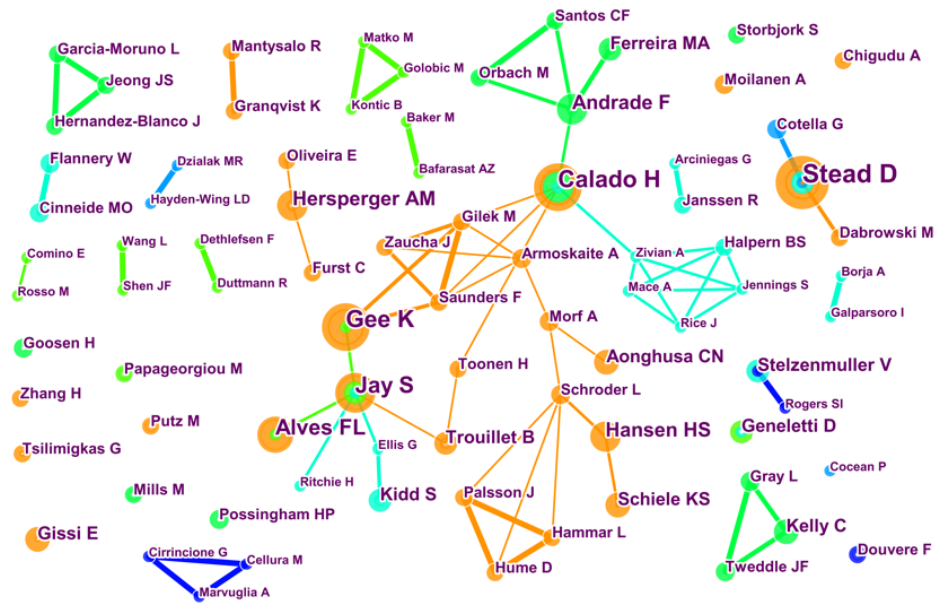
Figure 7. Visualization of the authors’ network (WOSCC).